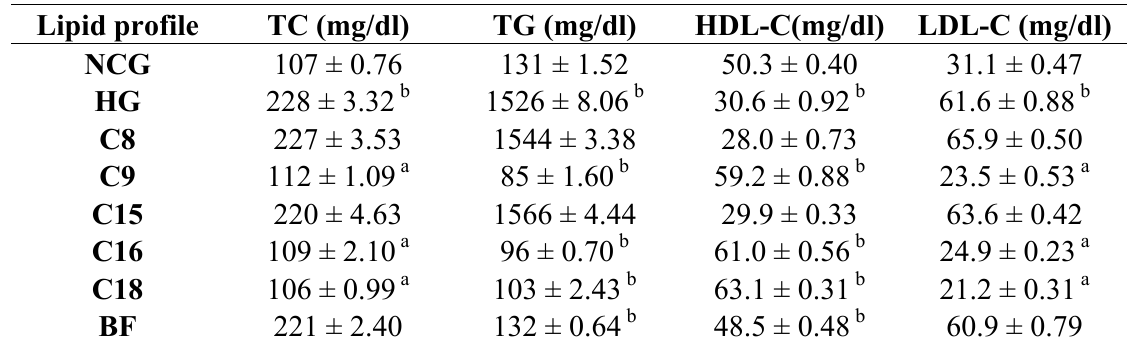
levels in Triton WR-1339-induced hyperlipemic rats after 12